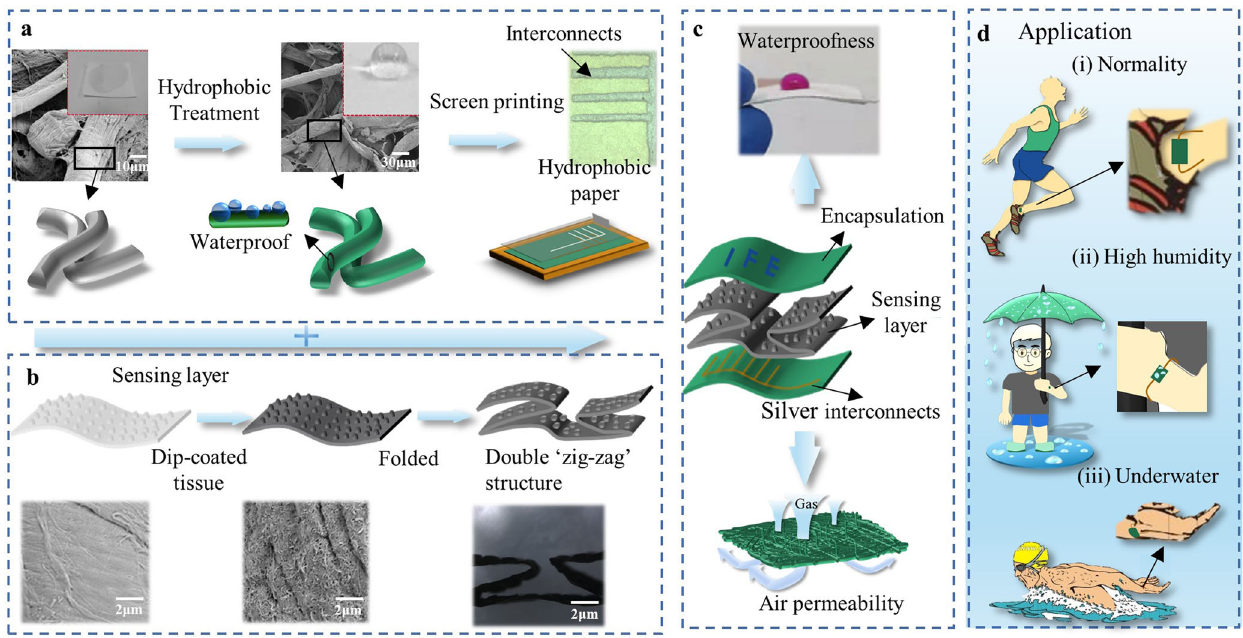
Fig. 1 Illustration for the fabrication and applications of a fully paper-based fl exible piezoresistive sensing system. a Preparation of hydrophobic paper and screen printing of the interconnects. b Preparation of the sensing layer with dotted surface and double ‘ zig-zag ’ structure. c Schematic diagram of the integrated fl exible piezoresistive sensor and its hydrophobicity and air permeability. d Different application scenarios of the fl exible piezoresistive sensing system, including Normal (i), high-Humidity (ii), and Underwater (iii) conditions. (This image does not contain any third party